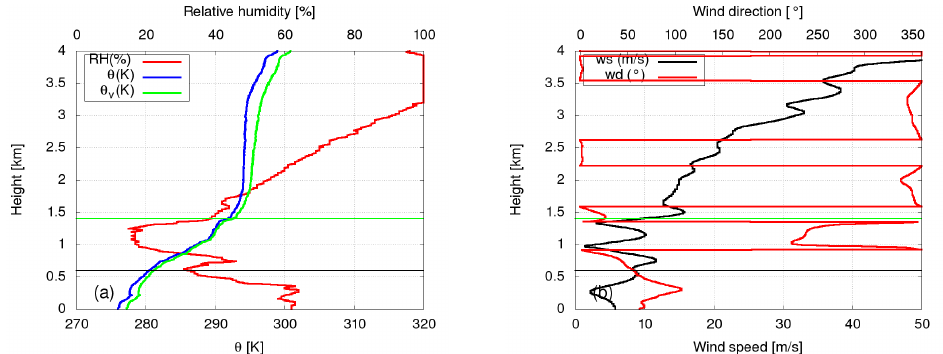
Figure 11. Radiosonde profiles from Rivolto, obtained on 22 December 2017 at 00:00 CET. Left : ( a ) potential temperature (blue), virtual potential temperature (green) and RH (red). Right : ( b ) wind speed (blue) and wind direction (red). Horizontal lines at 0.7km and 1.4km denote significant slope changes in the RH, potential temperature and wind speed profiles. The height is relative to